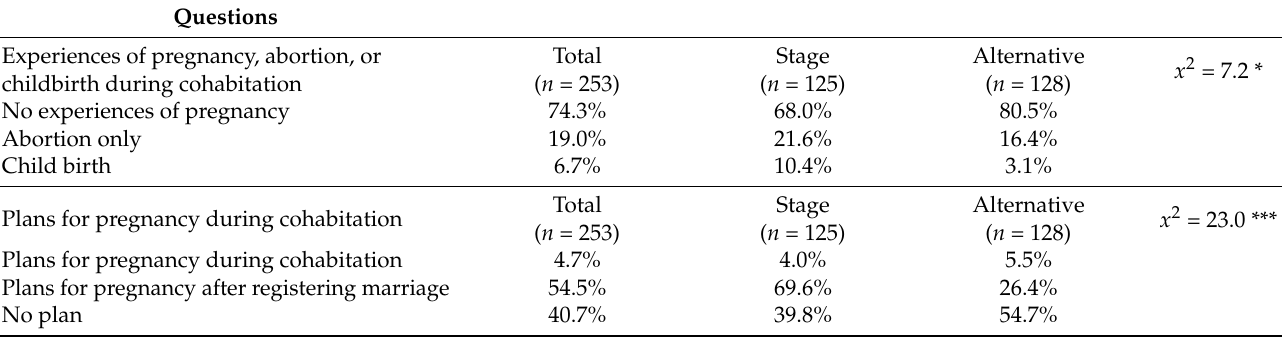
Table 6. ANOVA on cohabitants’ experiences by their view on cohabitation as a stage to marriage or an alternative to marriage ( n =